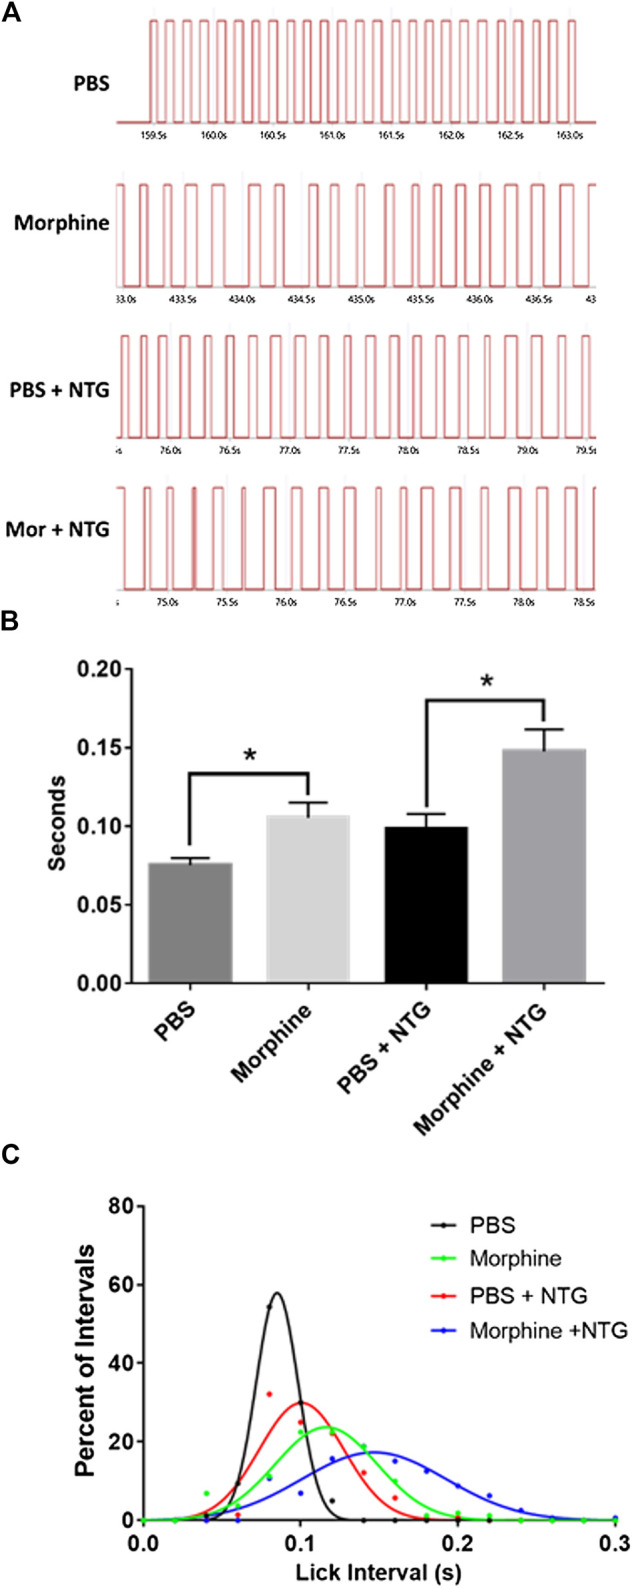
Nitroglycerin and morphine increase the interval between licks. (A) Representative licking bouts from animals treated with PBS, morphine (10 mg/kg), PBS + nitroglycerin (10 mg/kg), or morphine (10 mg/kg) + nitroglycerin (10 mg/kg) i.p. (B) Averaged interval between licks (Mean ± SEM). T-test PBS vs. morphine: t = 2.807 df = 14, p = 0.014. T-test PBS + NTG vs morphine + NTG: t = 2.819 df = 13, p = 0.015. N = 7 to 8 rats per treatment group. (C) Frequency distribution of intervals between licks. The data demonstrate the increased variability of the intervals in the presence of morphine and/or nitroglycerin. Data was fitted with Gaussian curves using PRISM statistical software.